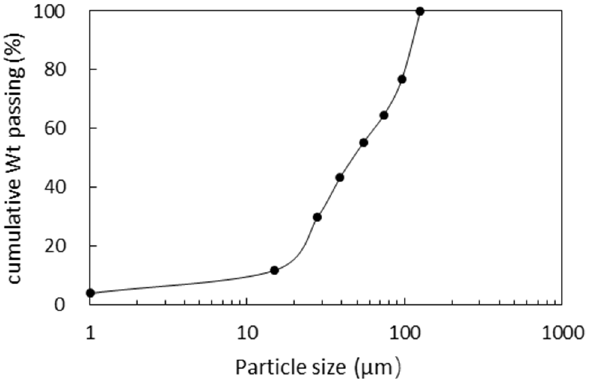
Figure 2. Particle size distribution of the feed sample obtained by wet sieving.